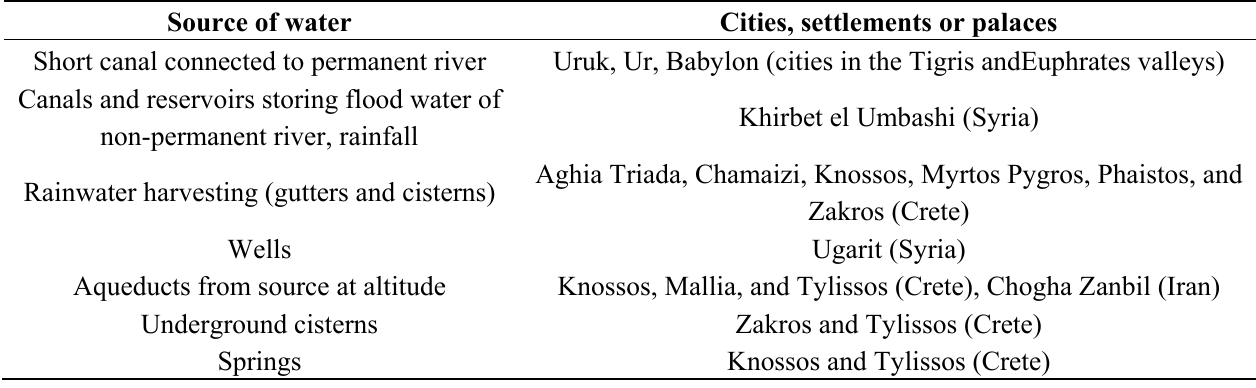
Table 1. Summary of sources of water for cities, settlements, and palaces in Mesopotamia and Ancient Crete during the Bronze Age (3300–1100 BC) (adapted from Viollet [4]; Tamburrino [3]).